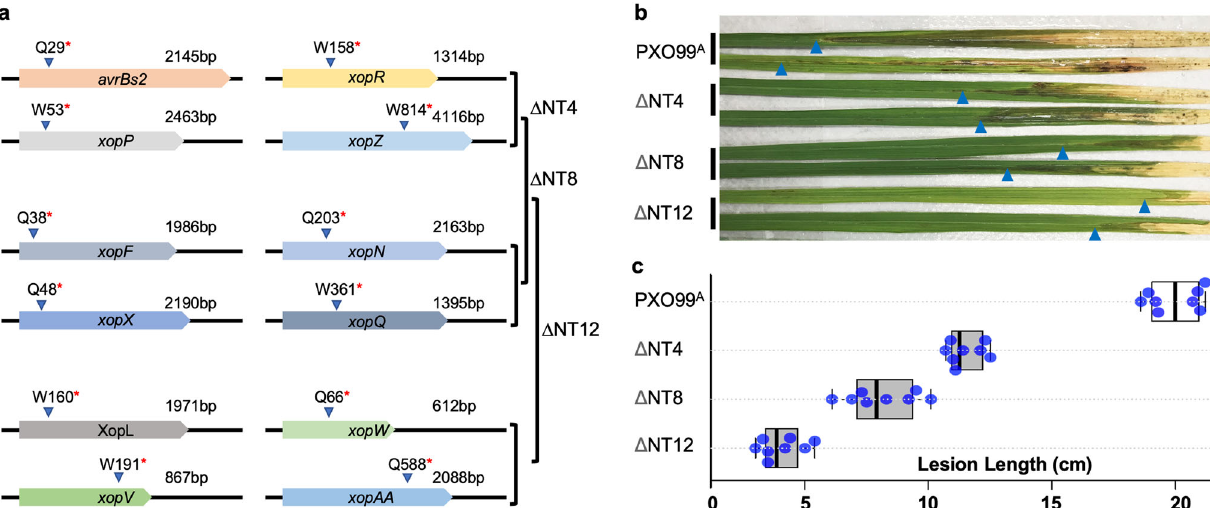
Fig. 5 Type III effector gene mutants created by multiplex base editing exhibit reduced virulence in rice. a Schematic structures (not in scale) of twelve type III effector genes with truncations as indicated by an asterisk for a premature stop codon. The quadruple ( Δ NT4), octuple ( Δ NT8), and duodecuple ( Δ NT12) mutants were sequentially generated in three rounds. b Lesion phenotypes of Kitaake caused by the respective Xoo strains as indicated at the left side of leaves with arrow heads pointing to the edges of lesions. c Lesion lengths in leaves of Kitaake rice caused by the respective Xoo strains as indicated at the left side of graphs. Boxes extend from 25th to 75th percentiles and display median values as center lines. Whiskers plot minimum and maximum values and individual data points. n = ~20 sample points. Two biological replicates were performed with similar results.